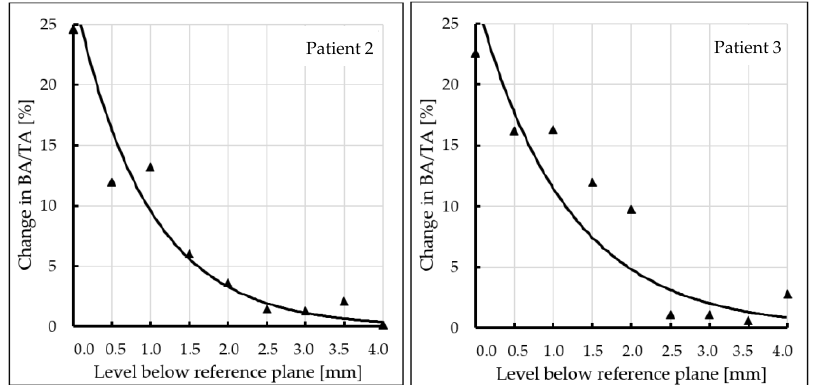
Figure 6. Changes in subchondral trabecular bone relative area (BA/TA, bone area/total area ratio) values in analyzed femoral head samples at different levels below the reference plane.